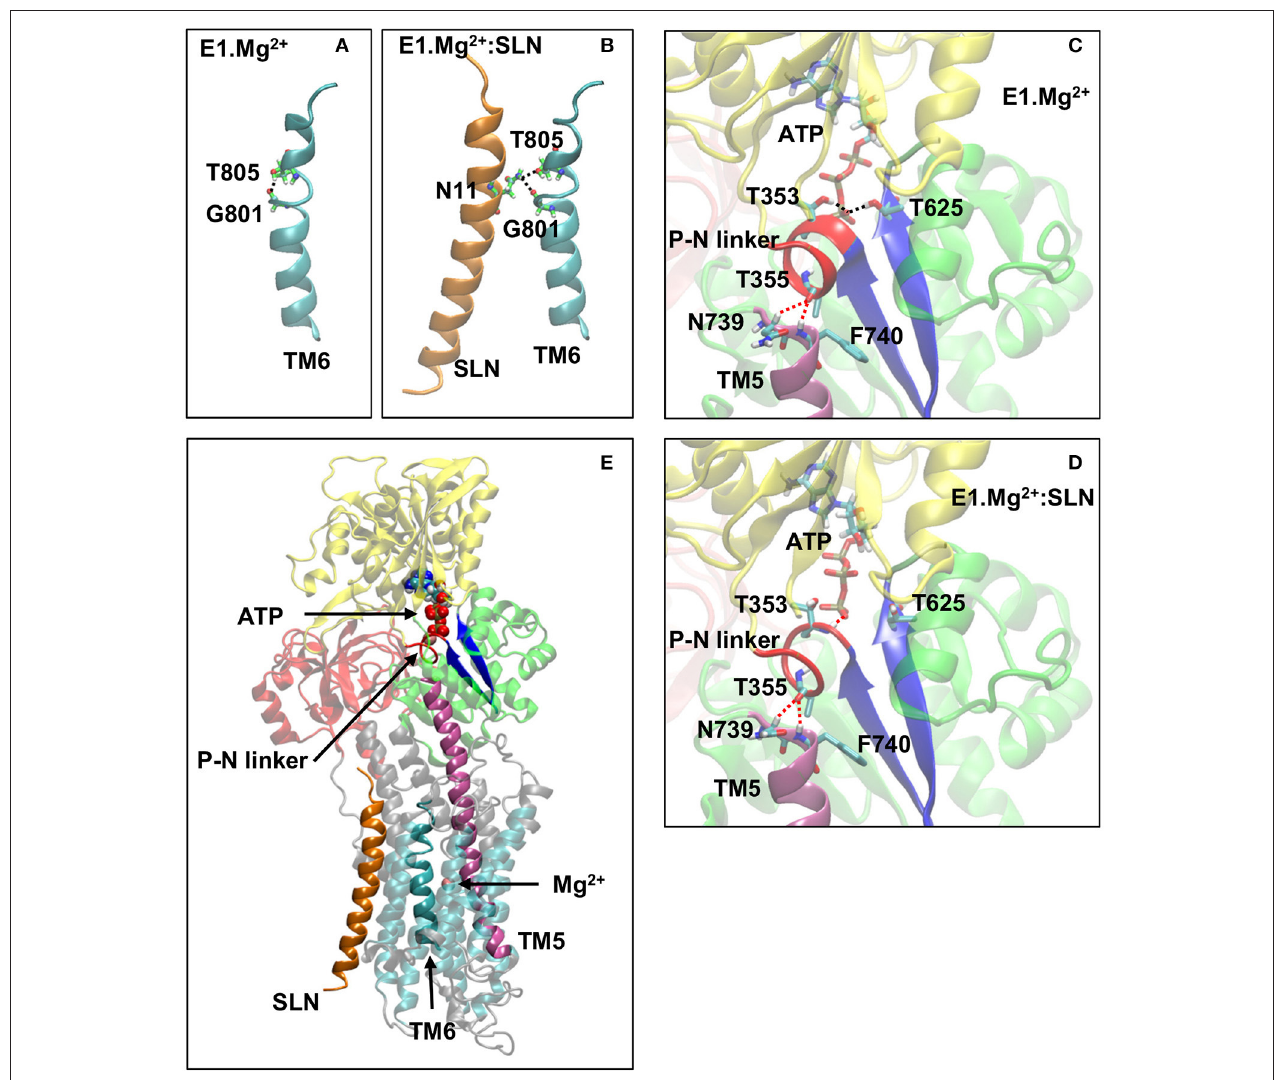
FIGURE 7 | A few key structural modifications between E1.Mg 2 + and E1.Mg 2 + :SLN. (A) and (B) Modification of the TM6 H-bonds in the absence and presence of SLN, respectively. (C) and (D) Modifications in the vicinity of ATP and the P-N linker in the absence and presence of SLN, respectively. D351 and Mg 2 + of the ATP are not shown for clarity. The important H-bonds are in black dashed lines and some distances in red dashed lines. In both cases, the distances between the hydrogen and oxygen atoms that are related by these dashed lines are as follows: (C) in E1.Mg 2 + , T355-N739 = 3.3 Å, T355-N740 = 2.4 Å, ATP-T353 = 1.9 Å, and ATP-T625 = 2.0 Å and (D) in E1.Mg 2 + :SLN, T355-N739 = 2.5 Å, T355-N740 = 2.5 Å, ATP-T353 = 2.2 Å, and ATP-T625 = 5.6 Å. (E) Zoom out where the protein is shown in transparency except for the elements that play an important role in the transmission of information from SLN to ATP to highlight their location. These elements